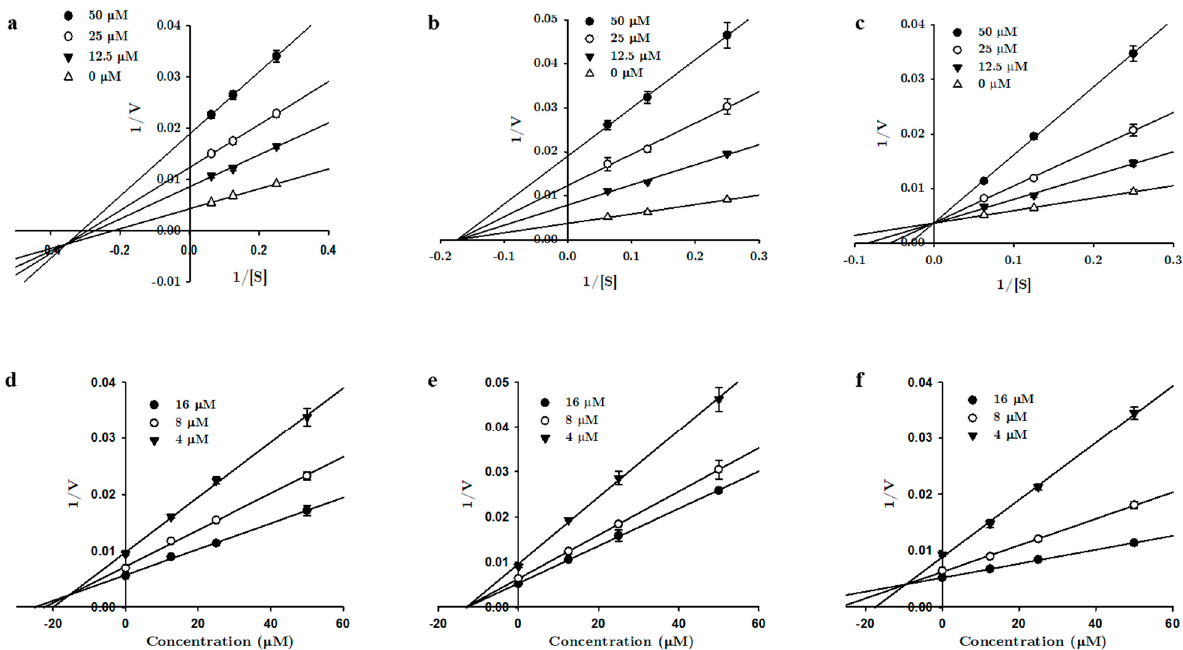
Figure 3. Lineweaver-Burk ( a − c ) and Dixon ( d − f ) plots of tanshinone I, tanshinone IIA, and cryptotanshinone for hMAO-B inhibition, respectively.